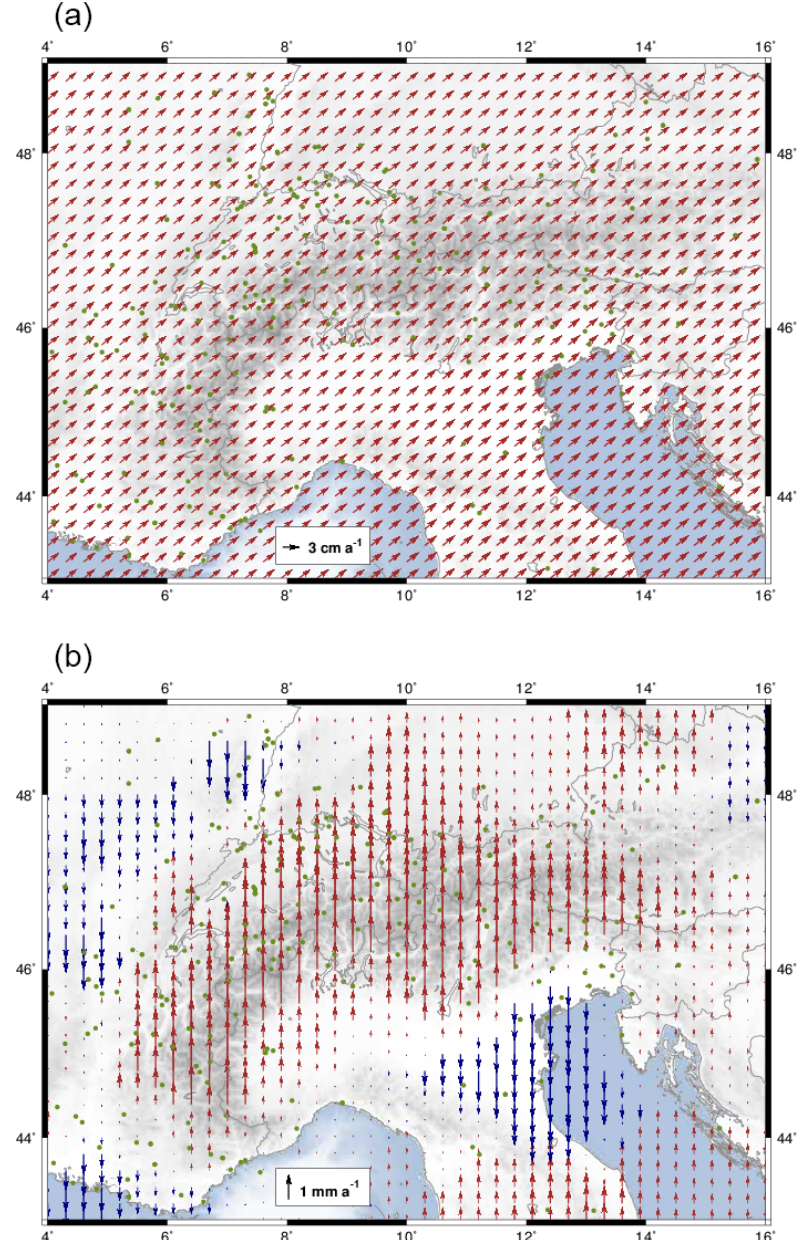
Figure 14. Continuous velocity field for the Alpine region referring to the ITRF2008 ( a : horizontal velocity field, b : vertical velocity field). Topography and bathymetry after the ETOPO1 model (Amante and Eakins,